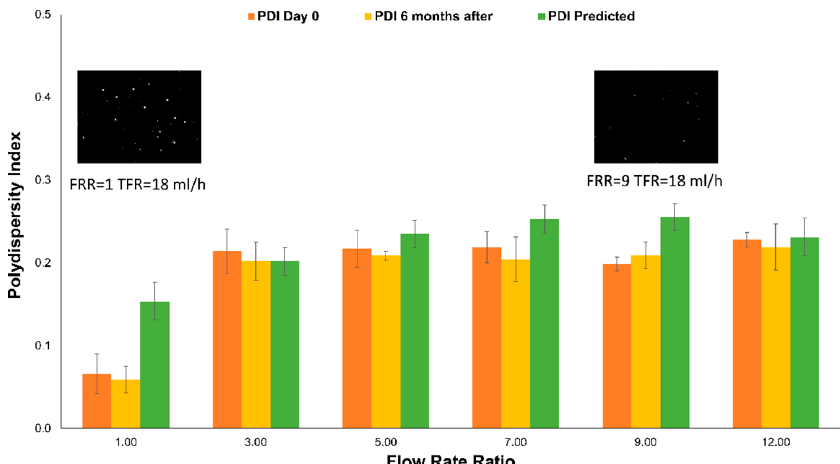
Figure 7. Liposomes PDI measurements immediately after production (orange), six months after (yellow), and the model prediction (green) at a constant TFR = 18 mL / h. n = 3, error bars indicate +/ − 1 SD for samples and SE fit for the model prediction. Images are taken from videos using NTA, as shown in supporting material Videos S1 and